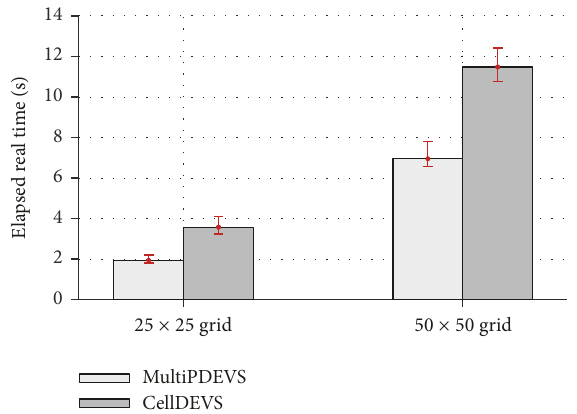
Figure 6: Performance comparison of multiPDEVS and Cell-DEVS showing elapsed real time in seconds of a fire spread simulation for a grid of 25 × 25 and a grid of 50 × 50 with a fixed simulation duration of 1200 and across 10 runs.